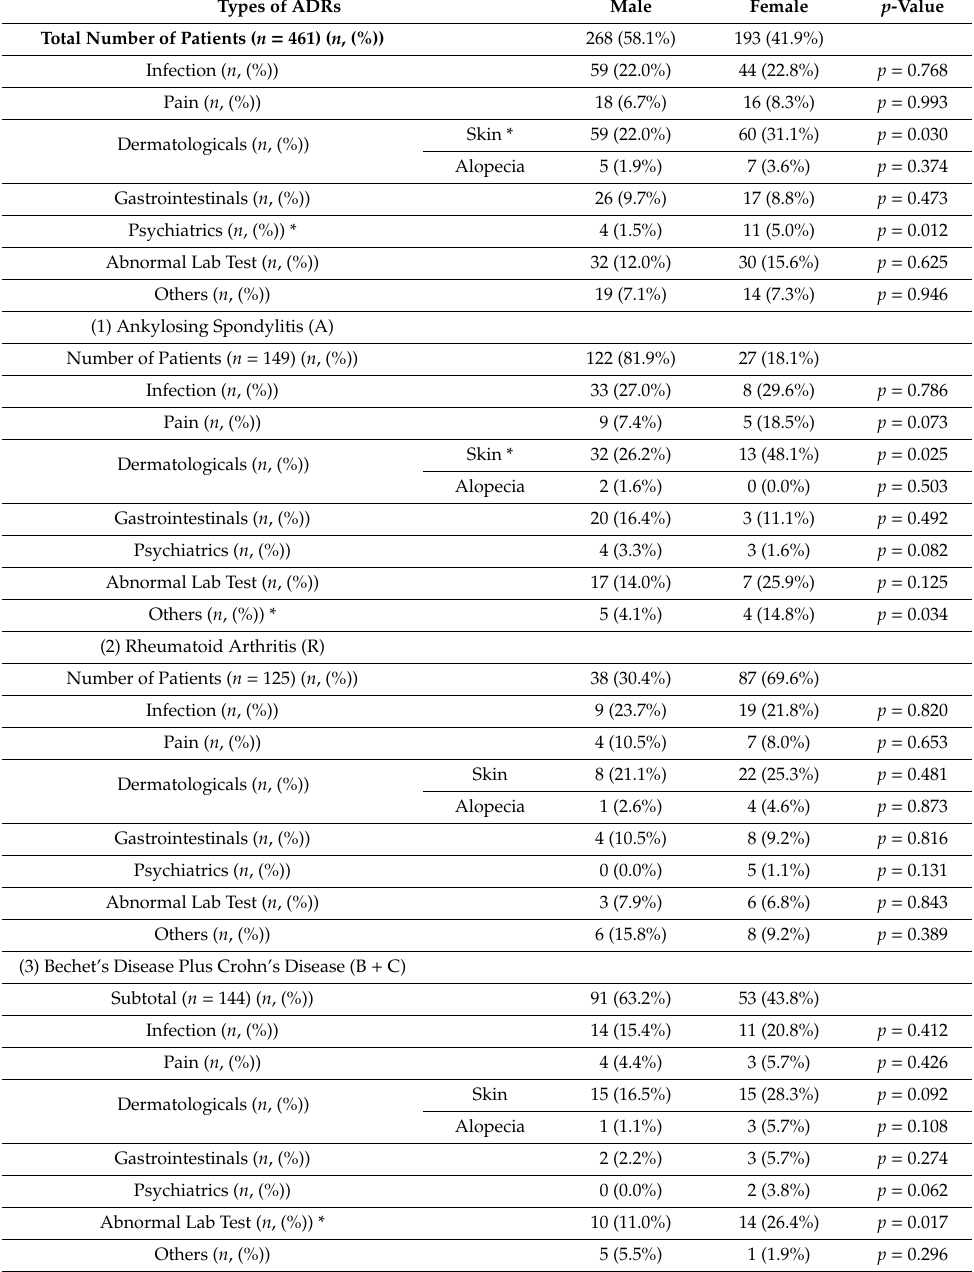
Table 3. Types of ADRs in male or female patients with di ff erent